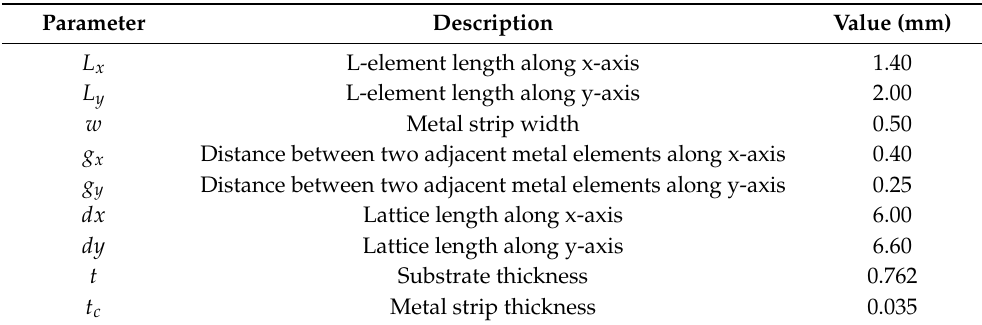
Table 2. Geometrical parameters of the L-shaped unit